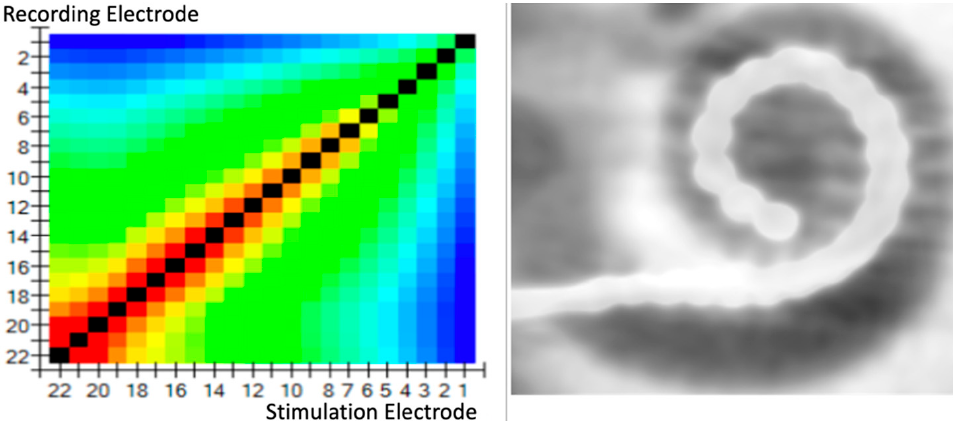
Figure 4. Correlation of TIM patterns with the radiological electrode position; homogeneous TIM.